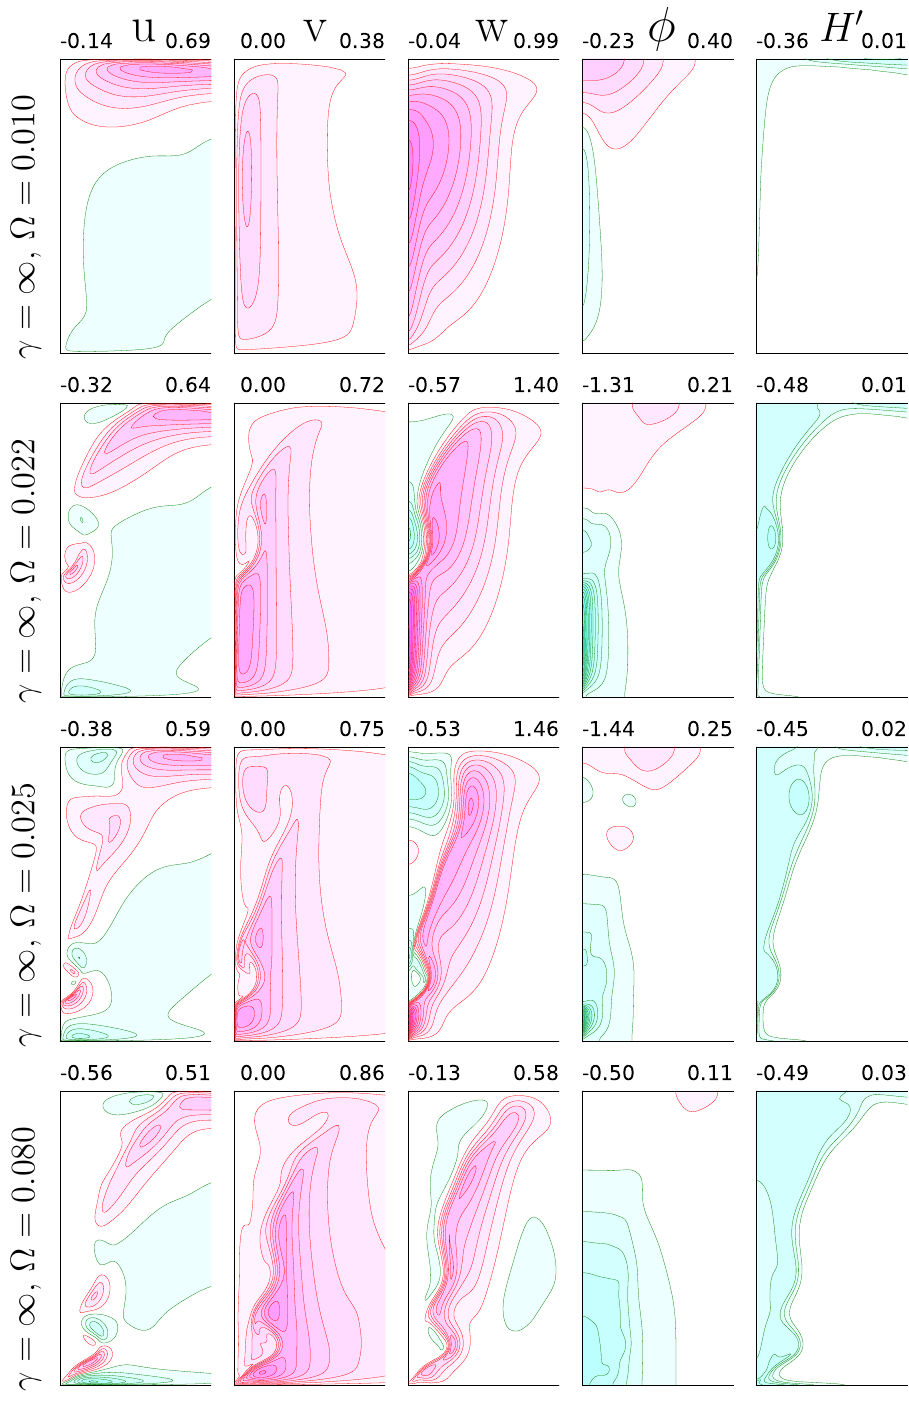
Figure 2. No-slip simulations, γ = ∞ , at t =